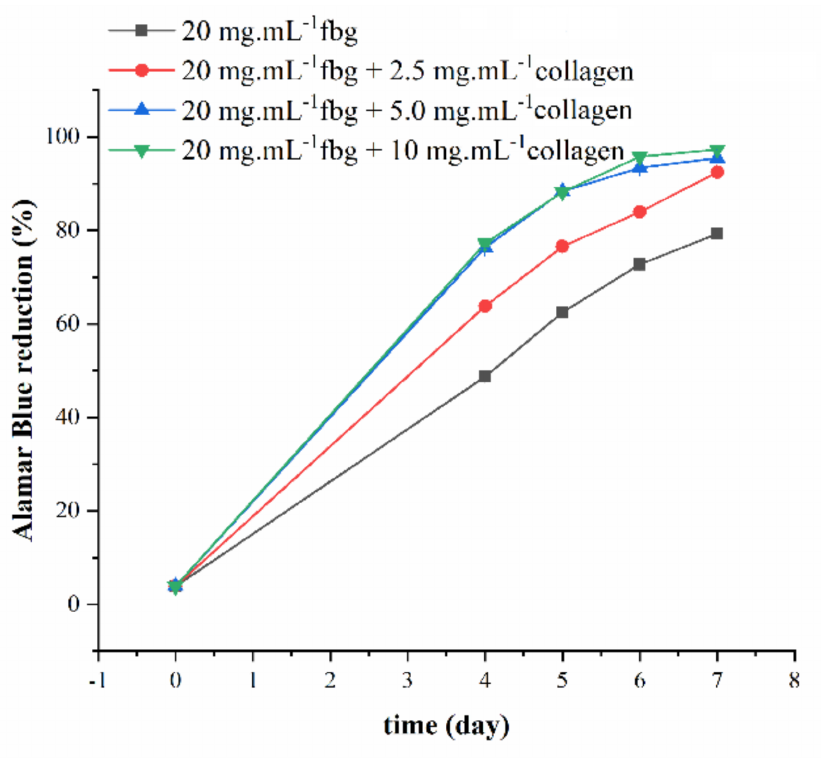
Figure 5. Proliferation of C2C12 cells on fibrin and fibrin-collagen composite gels as monitored by Alamar Blue test.